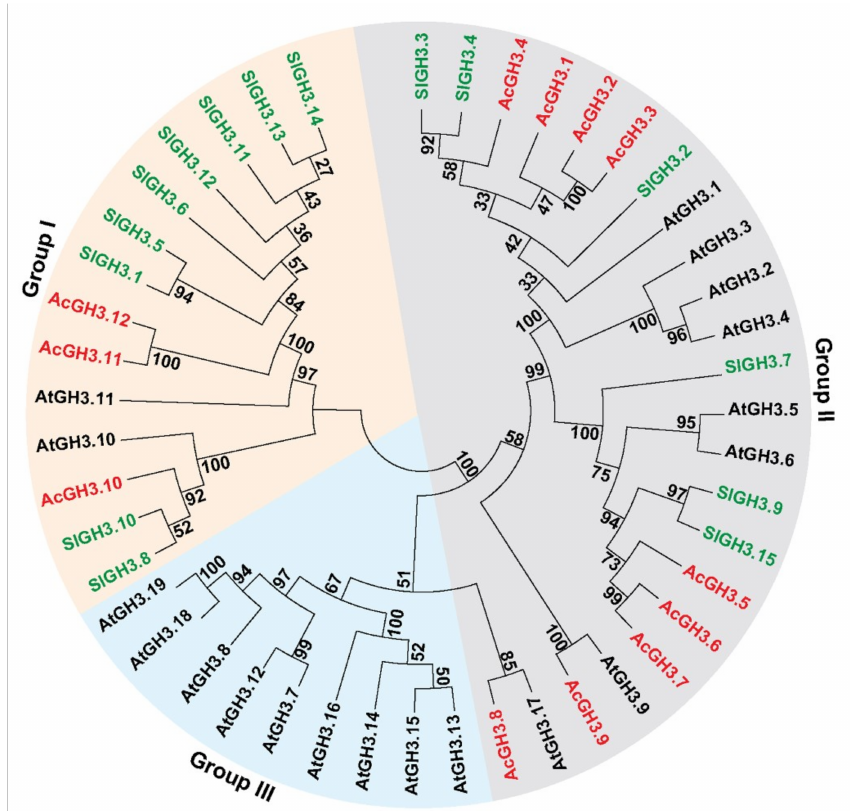
Figure 1. Phylogenetic tree derived from the amino-acid sequences of 12 AcGH3 genes in kiwifruit and 15 SlGH3 genes in tomato, and 19 AtGH3 genes in Arabidopsis . All the GH3 genes are divided into three groups (I–III), and numbers near branches represent bootstrap values. The red, green and black fonts indicate GH3s from kiwifruit, tomato, and Arabidopsis ,